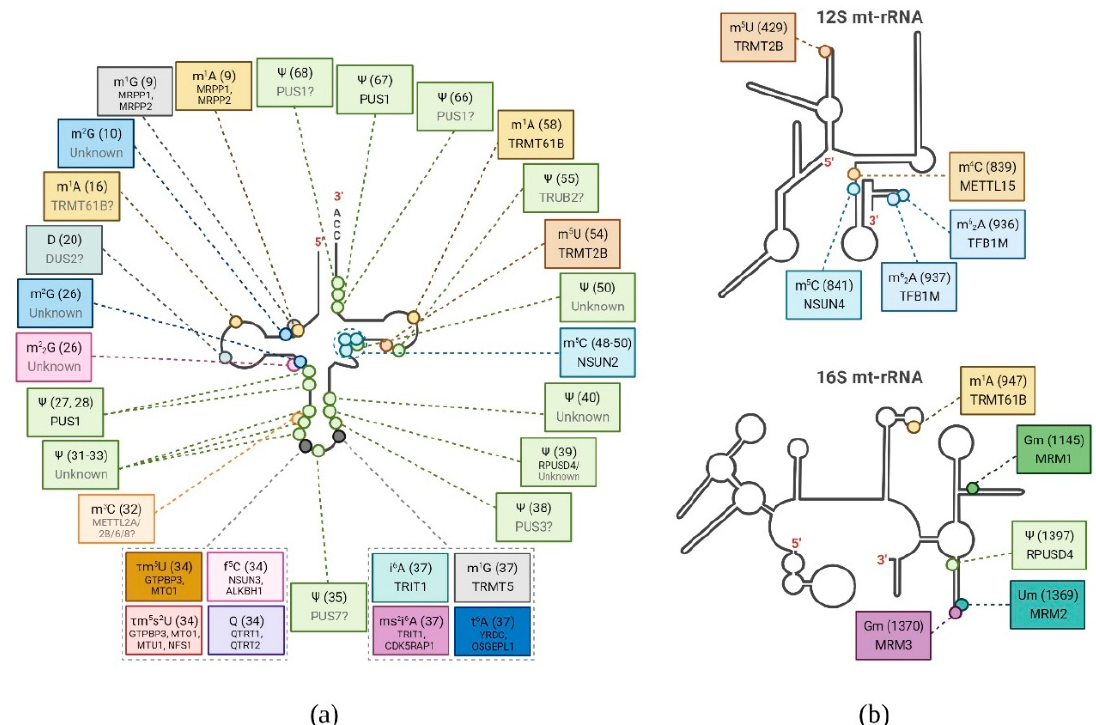
Figure 3. Summary of post-transcriptional base modification of human mt-tRNAs and mt-rRNAs. Schematic representation of the secondary structure of: ( a ) generic mt-tRNA; and ( b ) 12 S and 16 S mt-rRNA with indicated post-transcriptional base modifications (circles) identified in humans. Chemical modification, base position number (in brackets), and enzyme responsible (if known) for each position are depicted in boxes. The modifying enzymes predicted to be responsible for the indicated modification, but not experimentally confirmed, are indicated in gray and followed by a question mark. Modi- fications shown: 1-methyladenosine (m 1 A), 1-methylguanosine (m 1 G), N 2 -methylguanosine (m 2 G), dihydrouridine (D), N 2 , N 2 -dimethylguanosine (m 22 G), pseudouridine ( Ψ ), 3-methylcytidine (m 3 C), 5-taurinomethyluridine ( τ m 5 U), 5-tau- rinomethyl-2-thiouridine ( τ m 5 s 2 U), 5-formylcytidine (f 5 C), Queuosine (Q), N 6 -isopentenyladenosine (i 6 A), 2-methylthio- N 6 -isopentenyladenosine (ms 2 i 6 A), N 6 -threonylcarbamoyladenosine (t 6 A), 5-methylcytidine (m 5 C), 5-methyluridine (m 5 U), N 4 -methylcytidine (m 4 C), N 6 , N 6 -dimethyladenosine (m 62 A), 2 ′ - O -methylguanosine (Gm), and 2 ′ - O -methyluridine (Um). Created with BioRender.com.